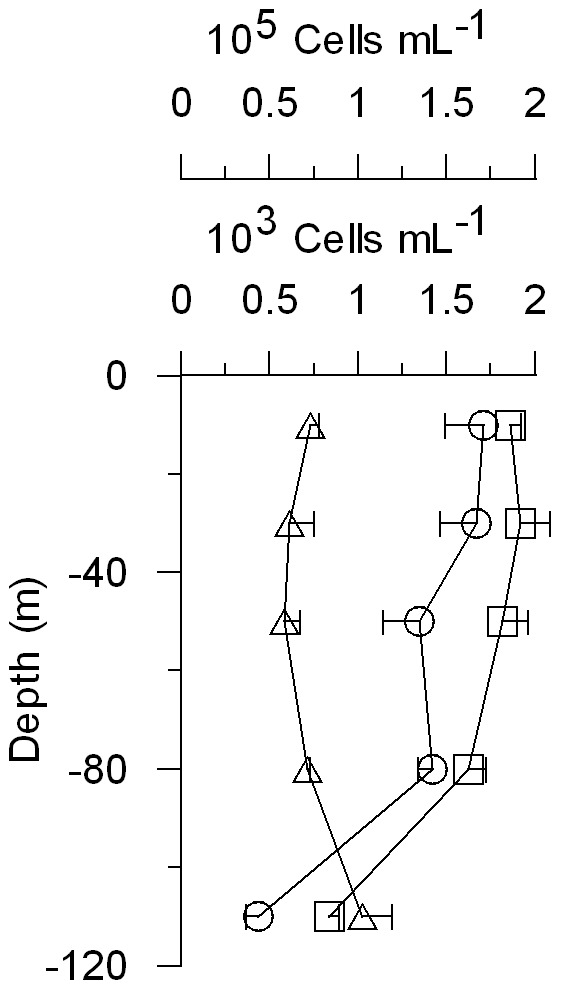
Picophytoplankton abundance during dilution experiments in EL.Vertical profiles of Prochlorococcus (rectangles), Synechococcus (circles) and picoeukaryotes (triangles) mean abundances up to the DCM. Symbols also point out sampling depths. Horizontal bars represent ± S.D. The 105 cells mL−1 scale is for Prochlorococcus, whereas Synechococcus and picoekaryotes scale is 103 cells mL−1.